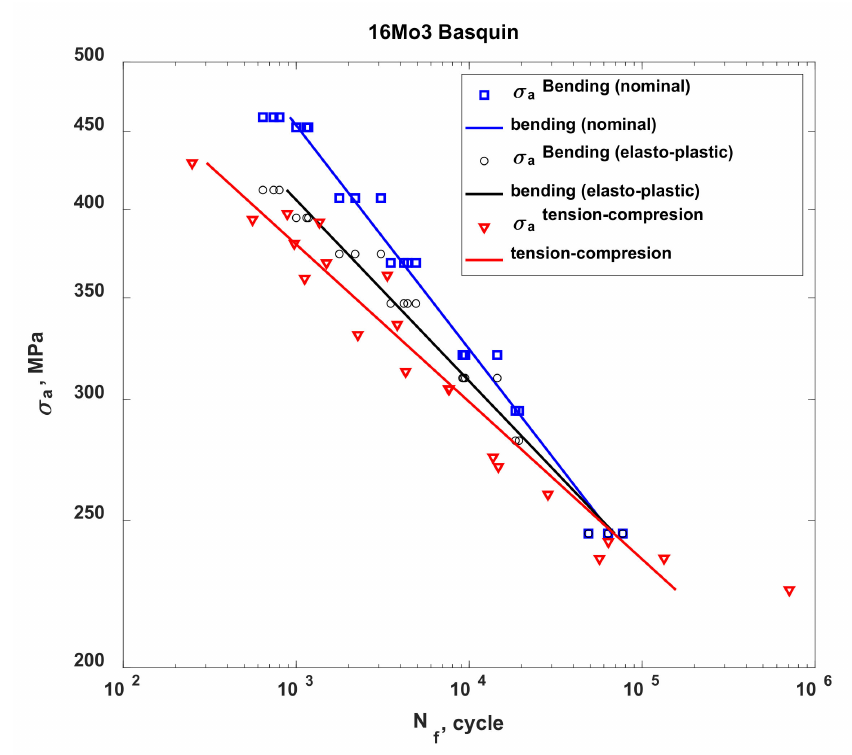
Figure 6. The stress characteristic for the 16Mo3 steel, developed for the cases of tension-compression and oscillatory bending.